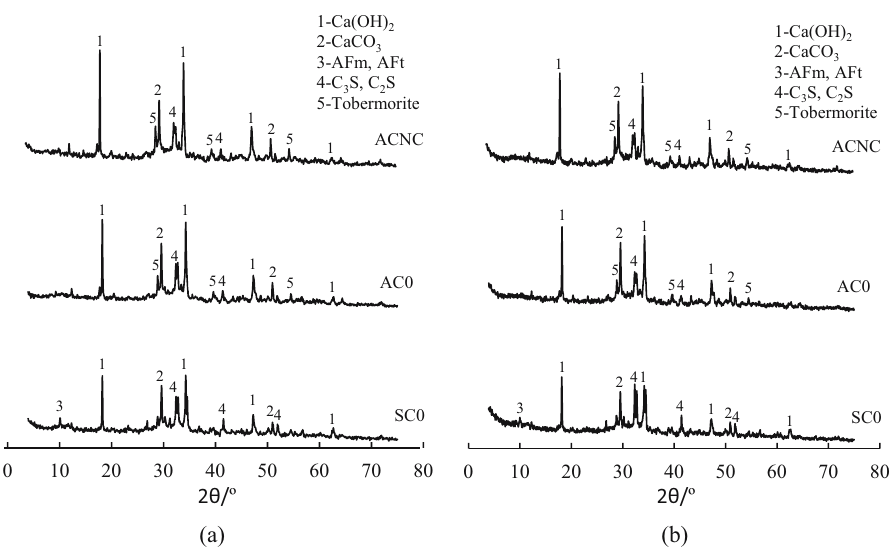
Figure 4: XRD patterns of cement paste samples at di ff erent ages ( a ) 28 d ( b ) 300 d.